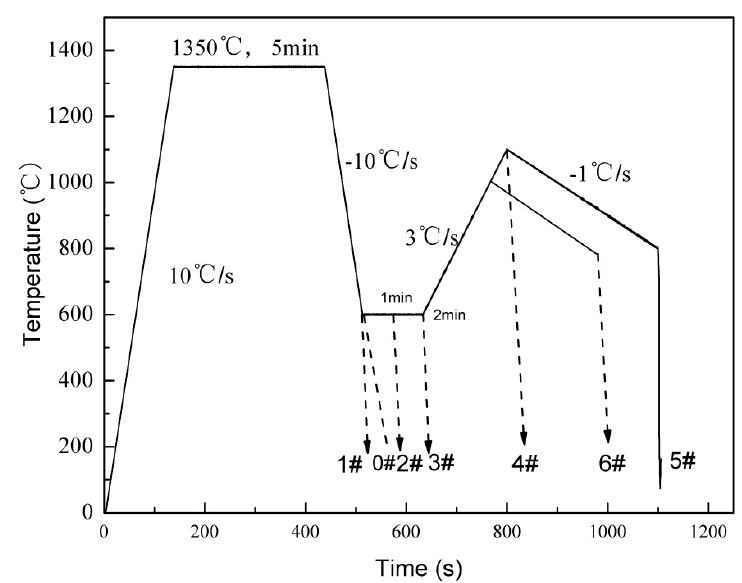
Figure 7. Temperature scheme curves by Gleeble ‐ 3500 thermal thermomechanical simulator.